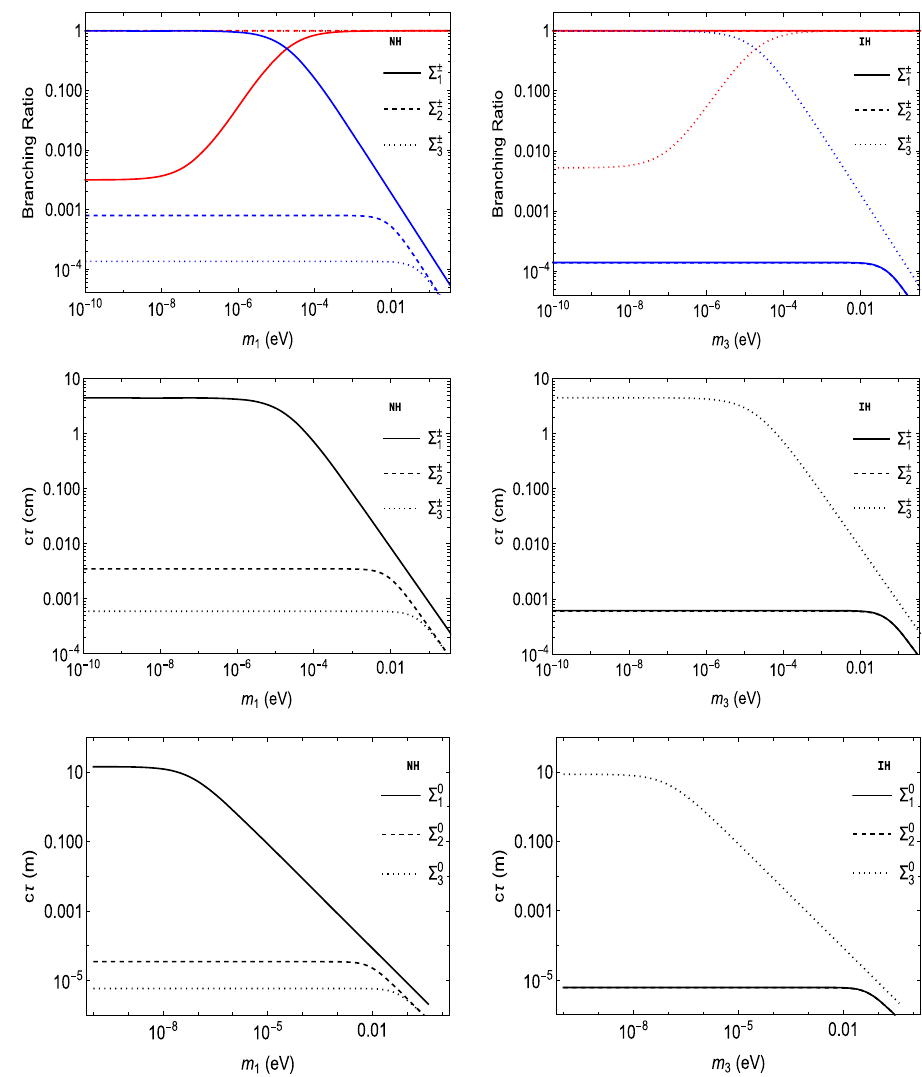
Fig. 9 For IH with = 600 GeV, m (cid:2) 1 = 1 TeV, x = 0 and m (cid:2) 1 , 2 , 3 2 , 3 y 1 , 2 , 3 = 10 − 3 , the left panels show the branching ratio (top), decay length of (cid:2) ± (middle) i and (cid:2) 0 (bottom) as a function of i the lightest observed neutrino mass ( m 3 ). All the line codings are the same as Fig. 7. The right panels show the same for the IH = 600 GeV, case, with m (cid:2) 3 = 1 TeV, x = 0 and m (cid:2) 1 , 2 , 3 1 , 2 y 1 , 2 , 3 = 10 − 3 as a function of